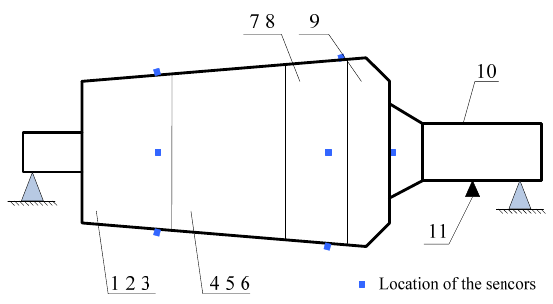
Figure 6. Illustration for structure of the aero-engine rotor and locations of the sensors: 1–9